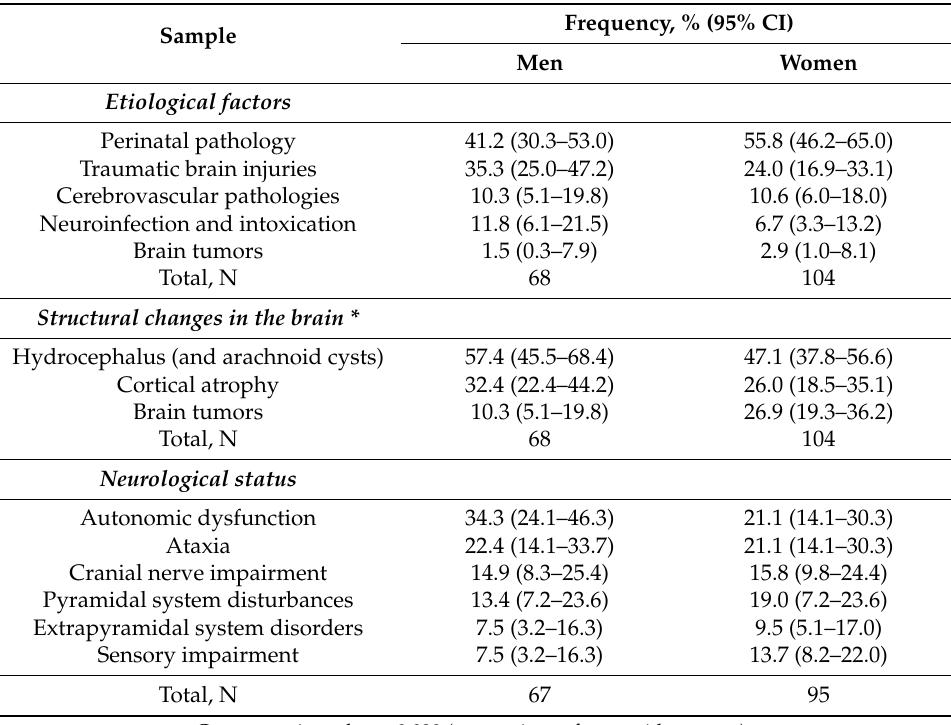
Table 6. Etiological factors, structural changes in the brain, and neurological status in patients with